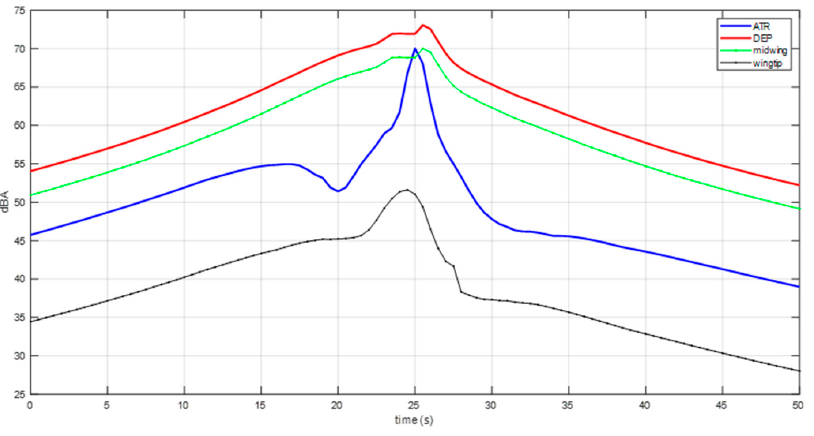
Figure 38. Comparison of the instantaneous sound levels of the two configurations.